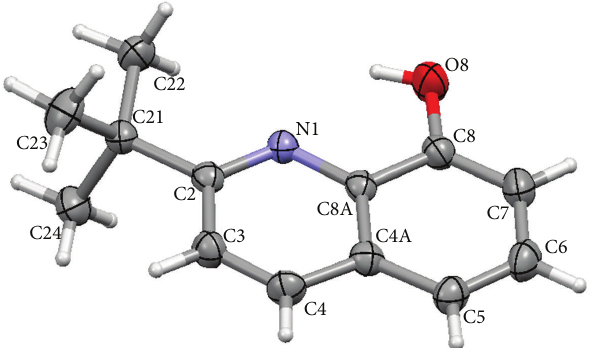
Figure 1: ORTEP diagram with atomic numbering scheme of 2-TB- 8-hq. Ellipsoids are drawn at the 30% probability level.